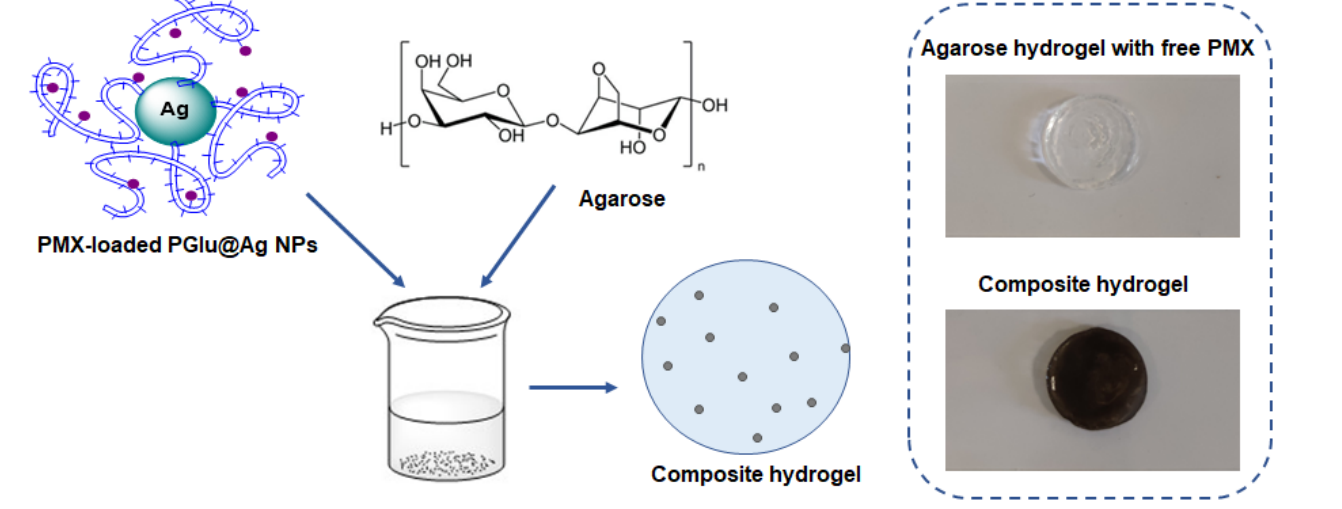
Figure 9. Scheme for the preparation of composite hydrogels with antimicrobial properties. The concentration of hybrid nanoparticles in the composite gel shown was 5 mg per specimen (0.3 mL of hydrogel).